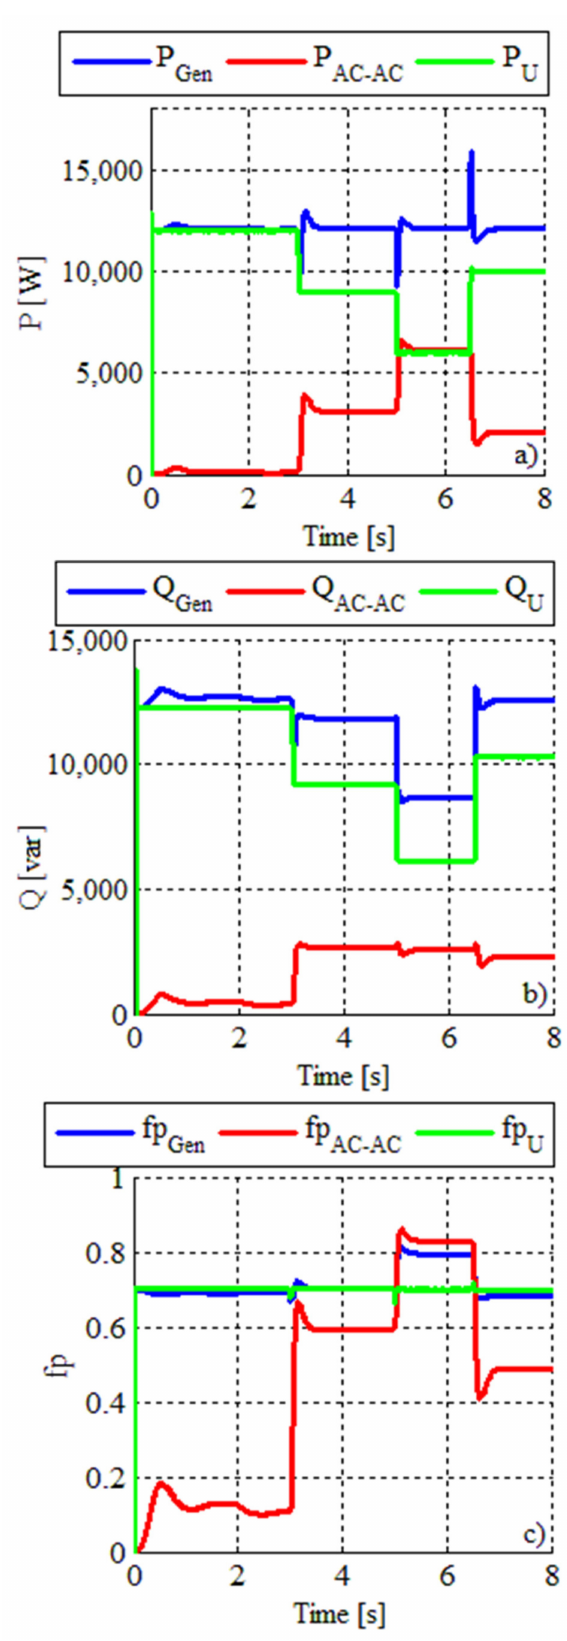
Figure 7. Graphics for ( a ) active power; ( b ) reactive power; and ( c ) the power factor with the AC-AC